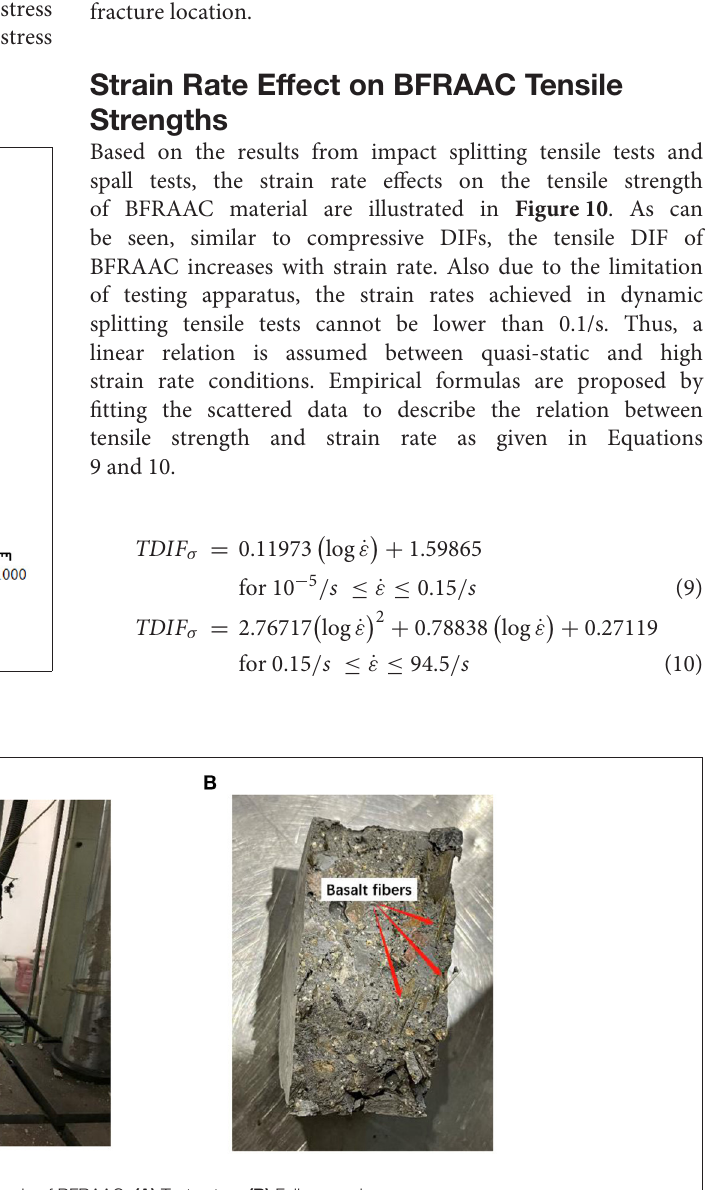
Frontiers in Materials |